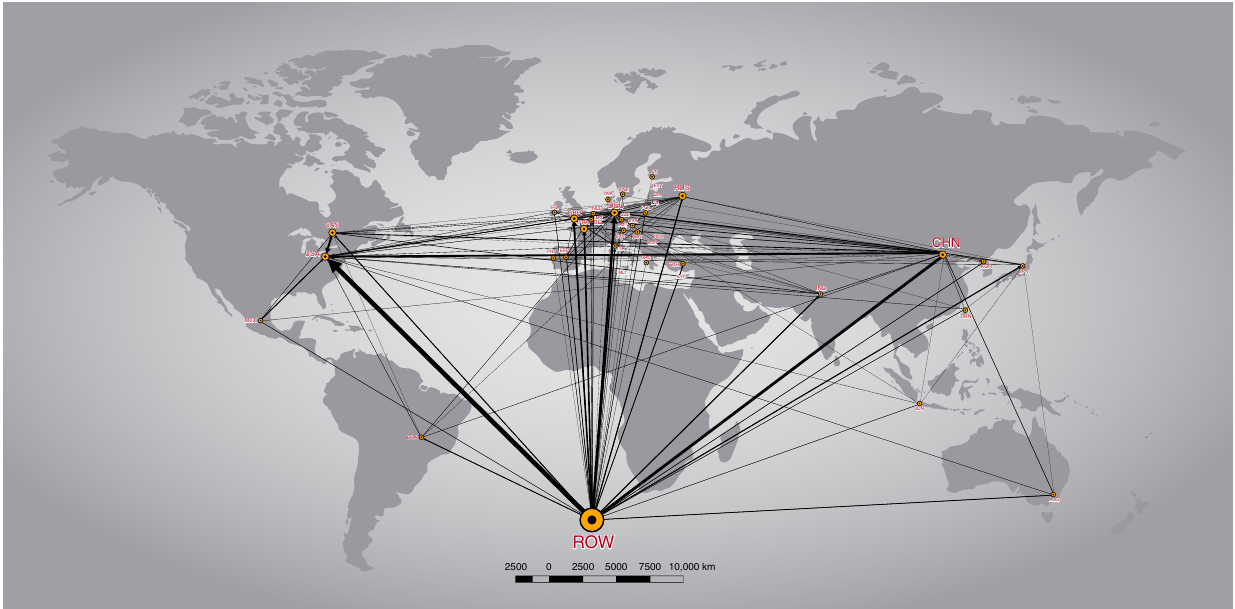
Fig. 5 Carbon fl ows embodied in US-MNEs ’ exports operating a broad. This study covers the following 27 EU countries and 13 other major countries (using ISO 3166 – 1 alfa-3 country codes): AUS, AUT, BEL, BGR, BRA, CAN, CHN, CYP, CZE, DEU, DNK, ESP, EST, FIN, FRA, GBR, GRC, HUN, IDN, IND, IRL, ITA, JPN, KOR, LTU, LUX, LVA, MEX, MLT, NLD, POL, PRT, ROU, RUS, SVK, SVN, SWE, TUR, TWN, and USA. The remaining non-covered part of the world is called ROW. Regions and countries with greater nodes are greater receivers of emissions fl ows embodied in international trade (US and ROW in red, followed by Germany in orange, and by the United Kingdom, France and India in brown). The ROW is arbitrarily placed at the bottom of the map for the sake of presentation. See Supplementary Data 5. This Figure has been created using the software Gephi, developed in Bastian et al.